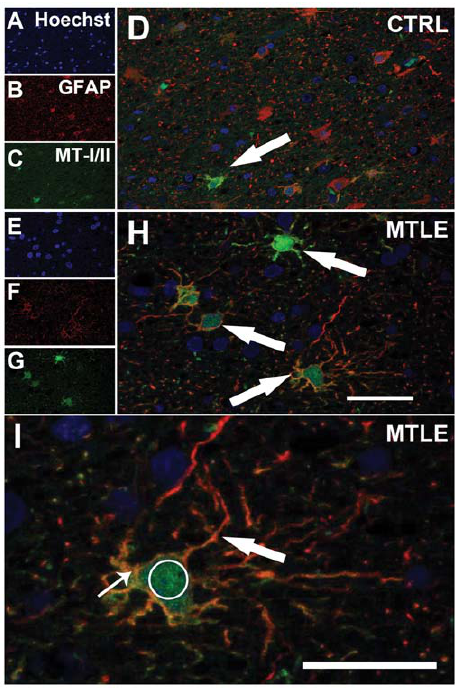
Figure 8. Confocal images of astrocytes expressing MT-I/II in Ctrl and TLE cases. TLE (E–H) patients presented more astrocytes (GFAP immunoreactive cells, red in B, F, D, H and I) expressing MT-I/II (green in C, G, D, H and I, indicated by white arrows in D and H) than Ctrl (A–D). In a detailed view of H (I), MT-I/II expression can be observed in radial branches (large arrow), soma (small arrow) and nucleus (Hoeschst 33342 staining, white circle) of astrocytes. Astrocytes are GFAP immunoreactivity) Bars in H and I indicate 50 micrometers.